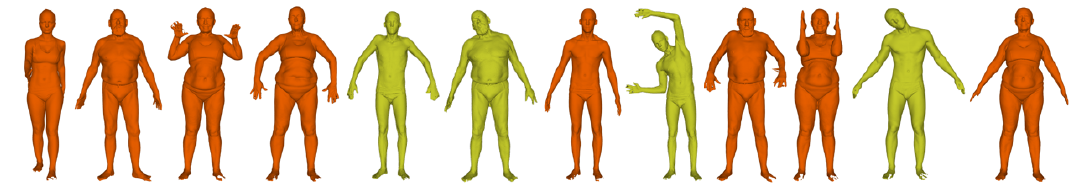
Figure 13. The 12 shapes with largest values of information entropy on the testing dataset of the FAUST, where orange colors indicate incorrect